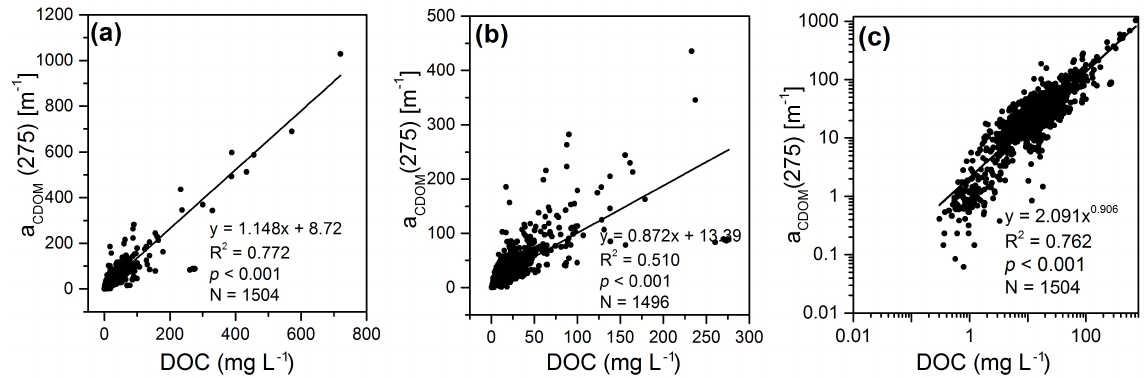
Figure 9. The relationships between a CDOM (275) and DOC concentrations. (a) Regression model with pooled dataset, (b) regression model with DOC concentration less than 300mgL − 1 , and (c) regression model with power fitting function based on a log-log